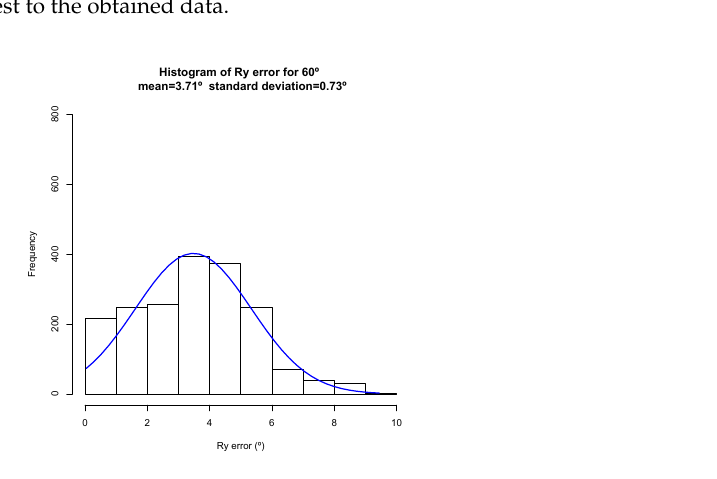
Figure 29. Histogram of R y for 60 ◦ of rotation. The curve in blue is the curve estimated by R as the Gaussian curve that is closest to the obtained